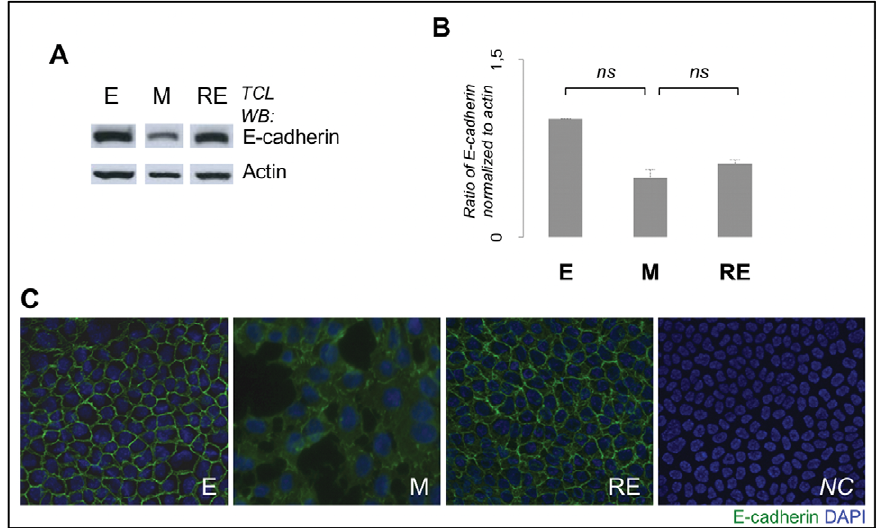
Figure 2. EMT/MET model validation. Panel A shows the Western blot for E-cadherin. Panel B illustrates the quantification of E-cadherin across the EMT/MET induction ( n =3 biological replicas). Data was normalized for E cells. Results are described as mean 6 standard error mean of 3 biological replicas. No significant differences were observed concerning E-cadherin expression ( ns stands for non-significant, p . 0.05). Panels A and B show that E-cadherin expression is decreased in M cells (in comparison to E cells) and partially recovered in RE cells (in comparison to M cells). Panel C represents the immunofluorescence for E-cadherin during EMT/MET induction (200 6 ). NC stands for negative control (no E-cadherin antibody used). Panel C illustrates the variation of E-cadherin localization during the EMT/MET induction: E cells display the classical E-cadherin expression at the cell membrane; M cells show a decreased expression of E-cadherin which is only observed in some points of intercellular contacts and in the cytoplasm; RE cells display E-cadherin expression in the cell membrane.